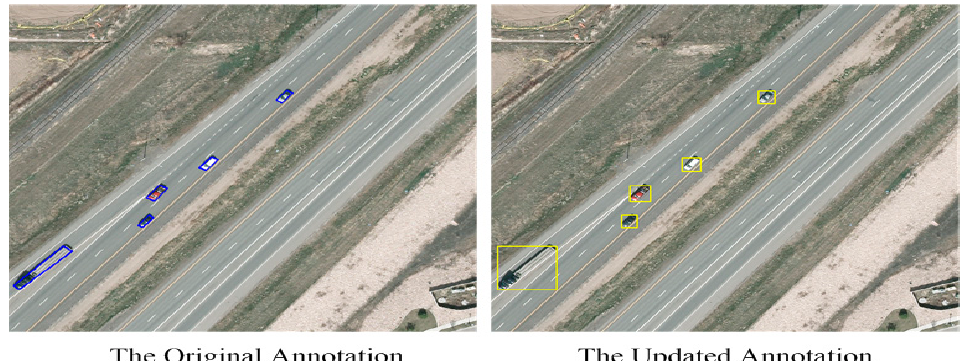
Figure 3. Examples of the original and updated annotations.